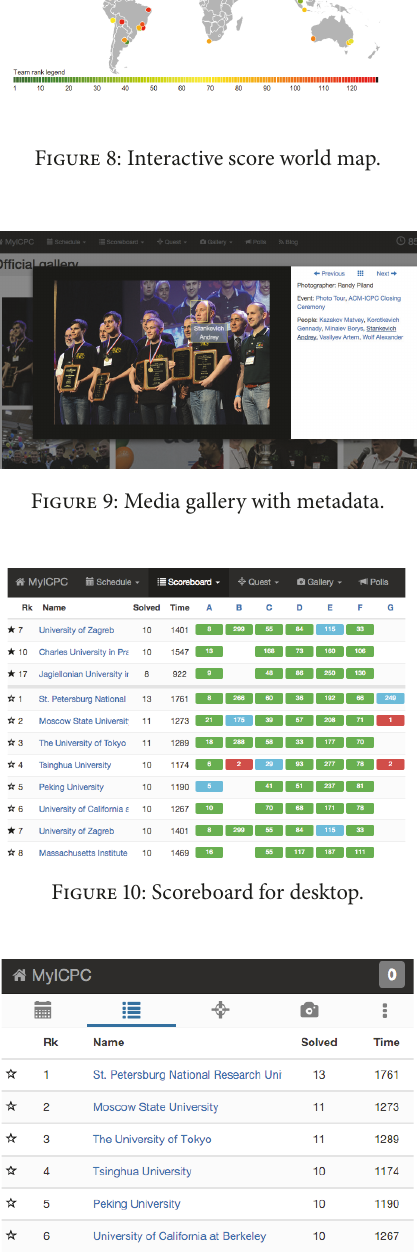
Figure 11: Scoreboard for